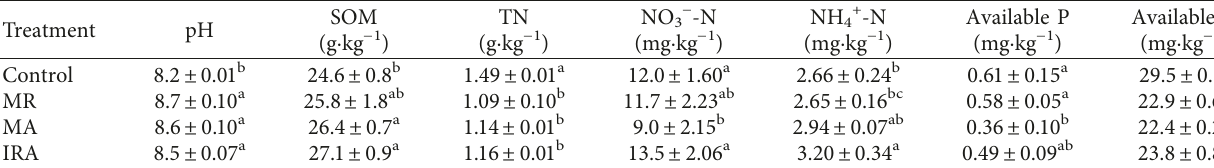
Table 5: The soil physical-chemical properties under different